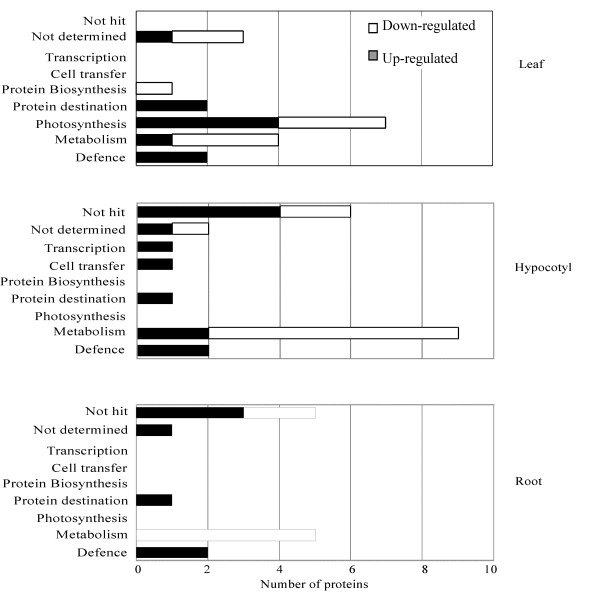
Functional distribution of identified proteins expressed in leaf, hypocotyl and root of soybean seedlings after NaCl treatment. After identification of proteins up- (black columns) and down- (white columns) regulated with NaCl treatment, the proteins were classified into 9 functional groups, which are: metabolism, photosynthesis, defense, cell transfer, protein destination and storage, protein synthesis, transcription, not hit and not determined.